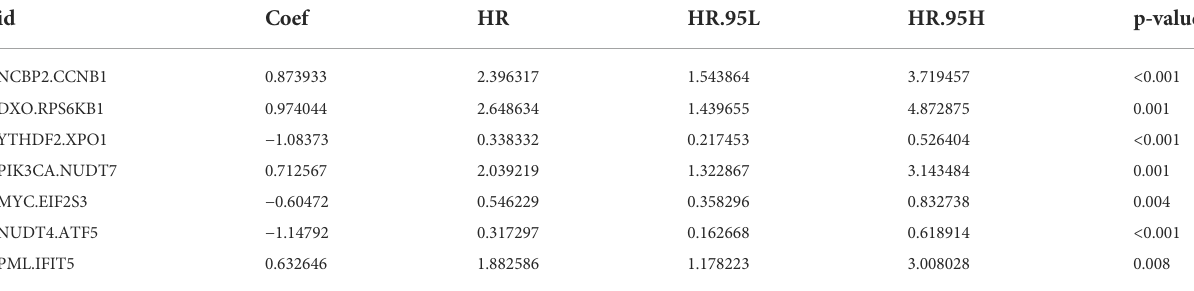
TABLE 1 Multivariate Cox regression analysis of 11 m7G pairs associated with overall survival in patients with CRC. id Coef HR